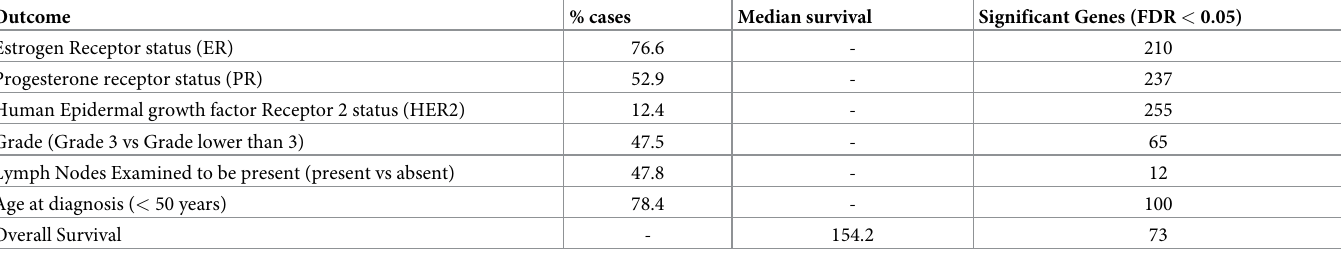
Table 2. Description of the seven breast cancer related outcomes analyzed, and the number of genes associated significantly. Outcome % cases Median survival Significant Genes (FDR < 0.05) Estrogen Receptor status (ER) 76.6 - 210 Progesterone receptor status (PR) 52.9 - 237 Human Epidermal growth factor Receptor 2 status (HER2) 12.4 - 255 Grade (Grade 3 vs Grade lower than 3) 47.5 - 65 Lymph Nodes Examined to be present (present vs absent) 47.8 - Age at diagnosis ( < 50 years) 78.4 100 Overall Survival - 154.2